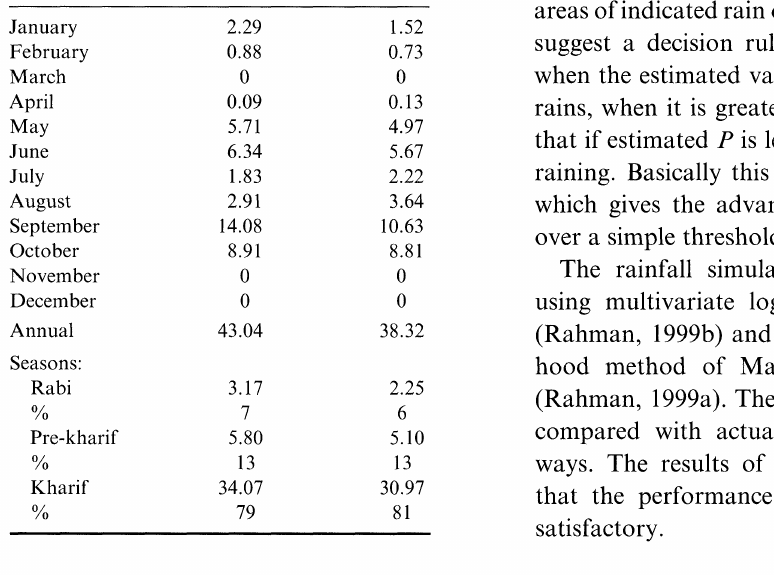
Summary comparison of average monthly rainfall of Barind Tract (Nazipur) Simulation